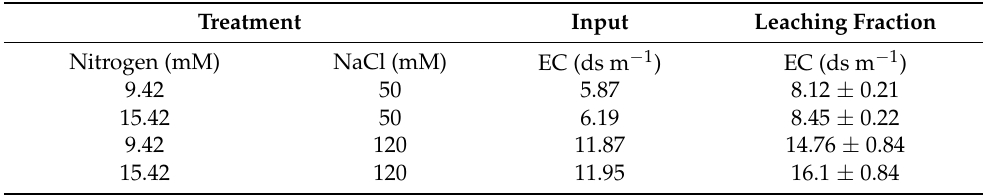
Table 1. Electrical conductivity (EC) (ds m − 1 ) of the input nutrient solution and leaching fraction. The means plus standard errors ( ± SE) are shown, n =